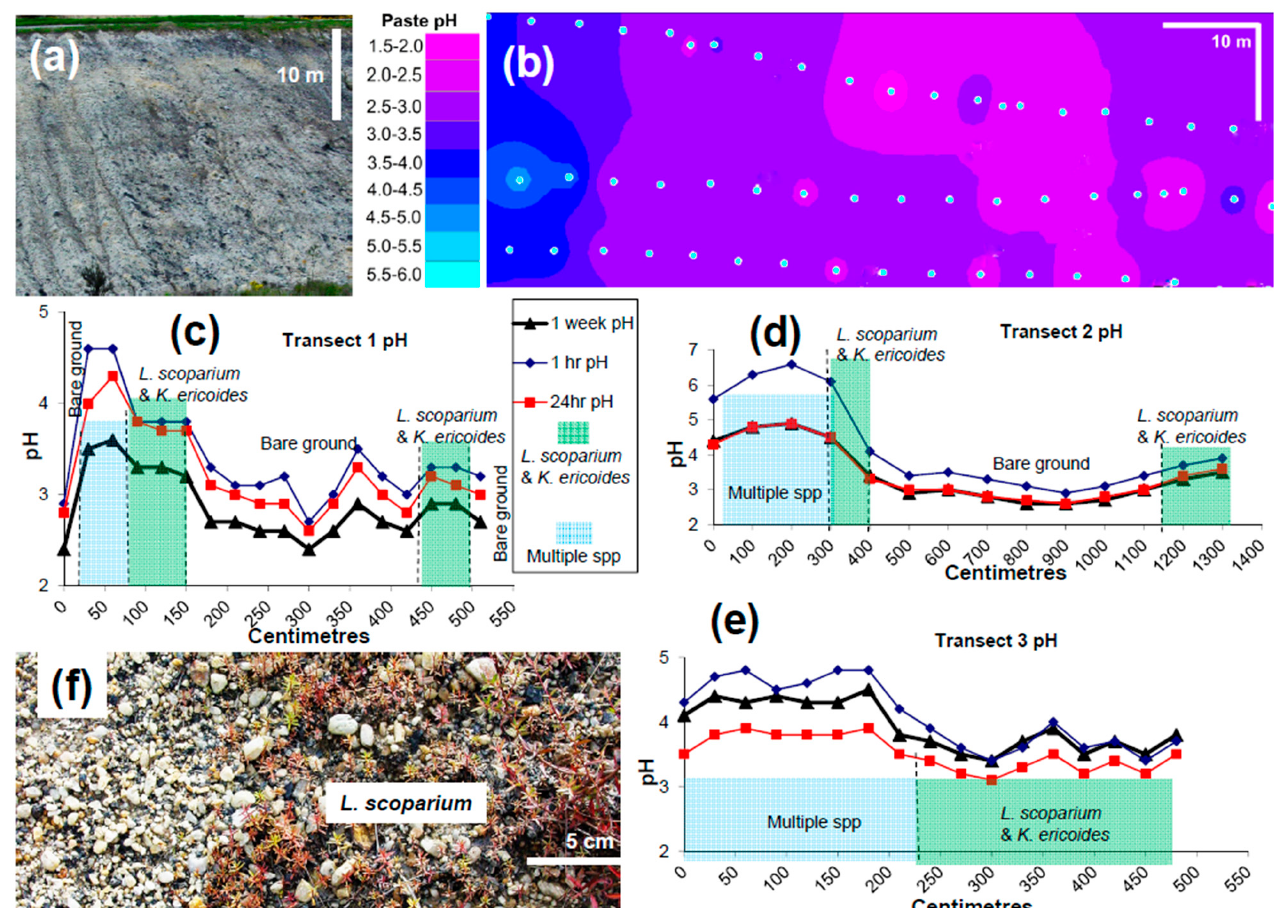
Figure 7. Acid features at Wangaloa historic coal mine. ( a ) Photograph of part of the most acidic waste rock slope after initial stages of rehabilitation in 2004. ( b ) Contoured paste pH data for the whole slope in a, measured in 2004. White circles are sample points. ( c )–( e ) Three acidity gradients showing paste pH values measured in the field (1 h) in relation to pH after 24 h and one week. Locations of L and K colonisation and more general plant establishment are indicated. ( f ) Photograph of L. scoparium seedlings becoming established near to the pH 3 threshold on the acid slope in 2015. Red colouring of some seedlings is a result of acid-related stress.